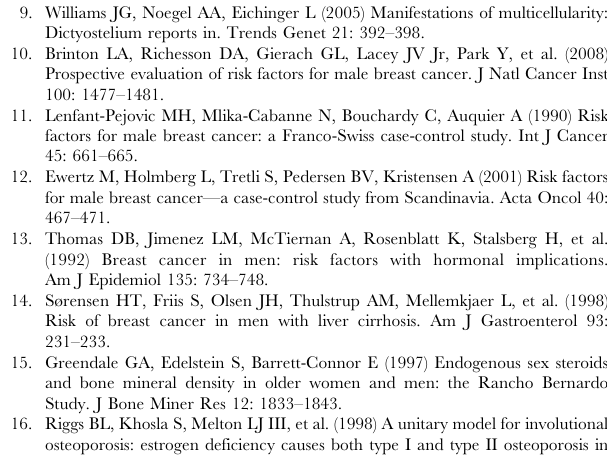
male and female rats maintained on a HFG diet. Significantly